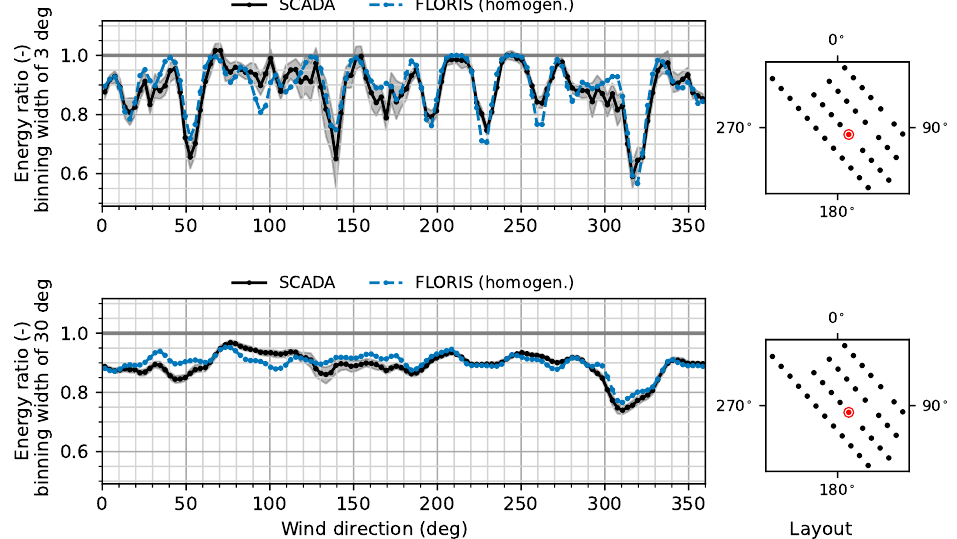
Figure 19. Energy ratio curves for Turbine 16 in the OWEZ wind farm, where the reference turbines are all upstream turbines within a 5 km radius, and the reference wind direction is the average of the nacelle headings of turbines 3, 15, 17, and 24. The shaded regions represent 90% confidence intervals obtained through bootstrapping. The layout schematic on the right shows the location of Turbine 16 in the wind